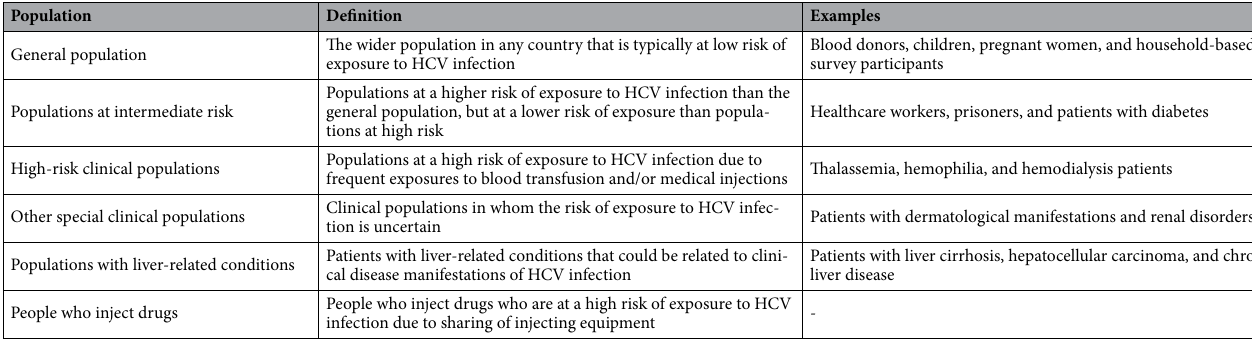
Table 1. Population classification based on the risk of exposure to HCV infection. Abbreviations: HCV, hepatitis C